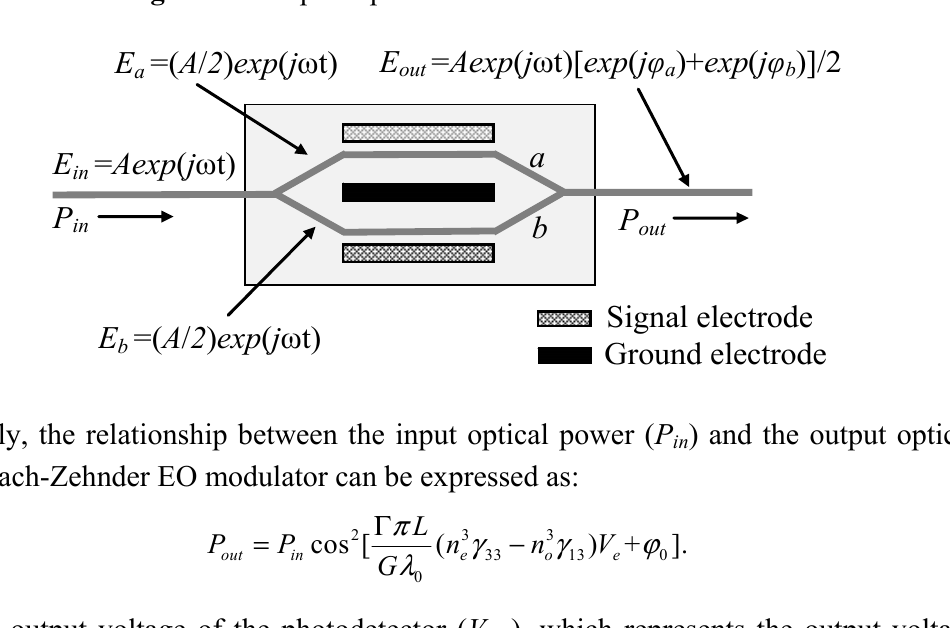
Figure 3. The principle of Mach-Zehnder EO